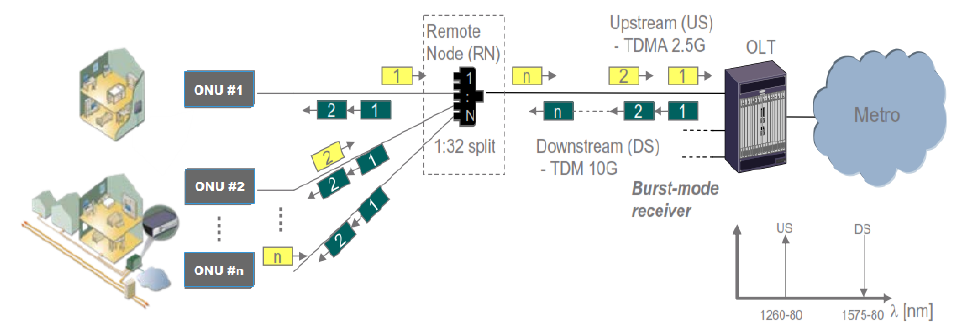
Figure 1. Typical architecture of 10G-Passive Optical Network (XG-PON) network.